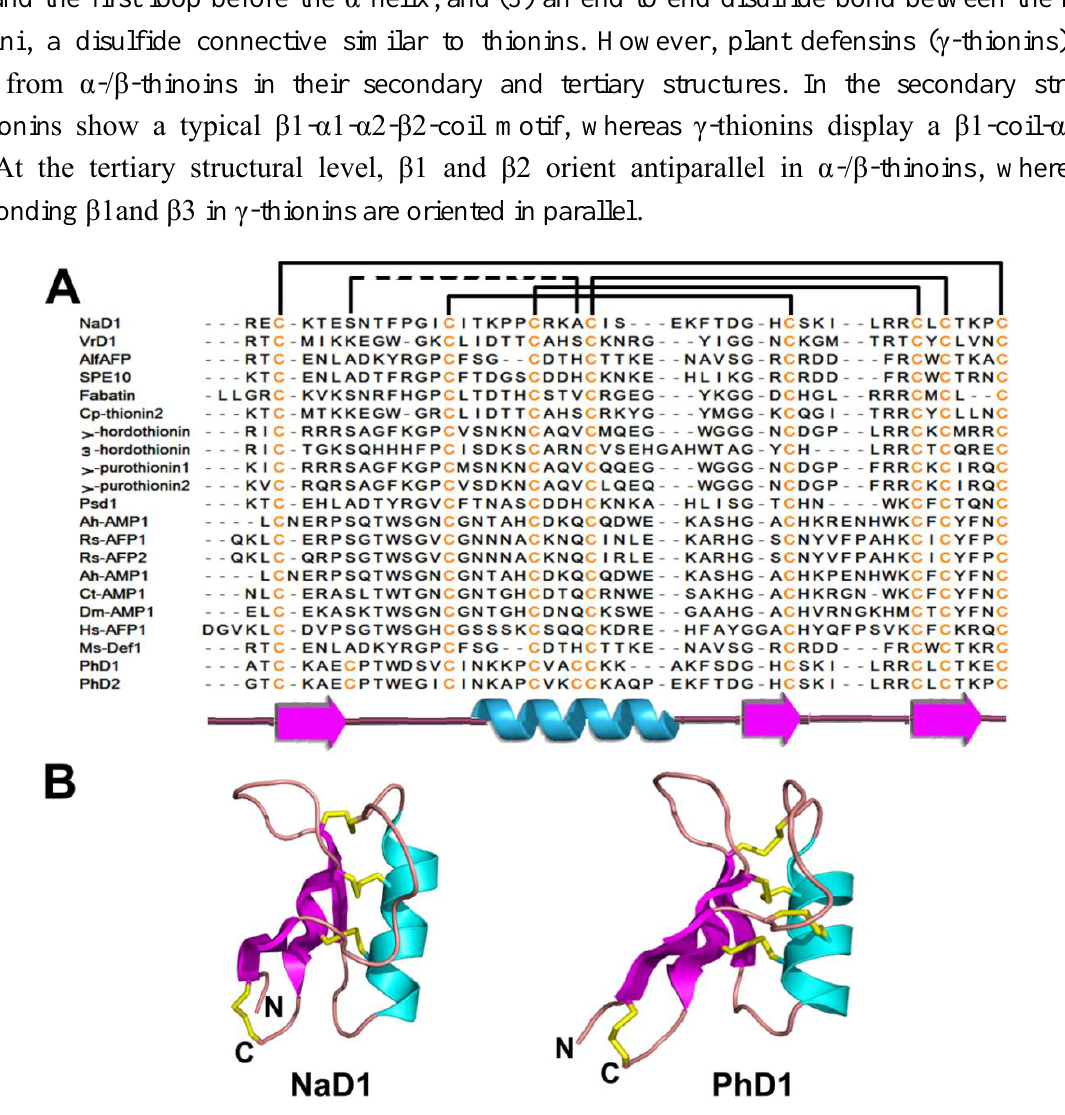
Figure 3. Sequences ( A ) and structures ( B ) of representative plant defensins. The secondary structure is represented by different colors: cyan-α helix; magenta-β strand; pink-random coil and yellow-disulfide